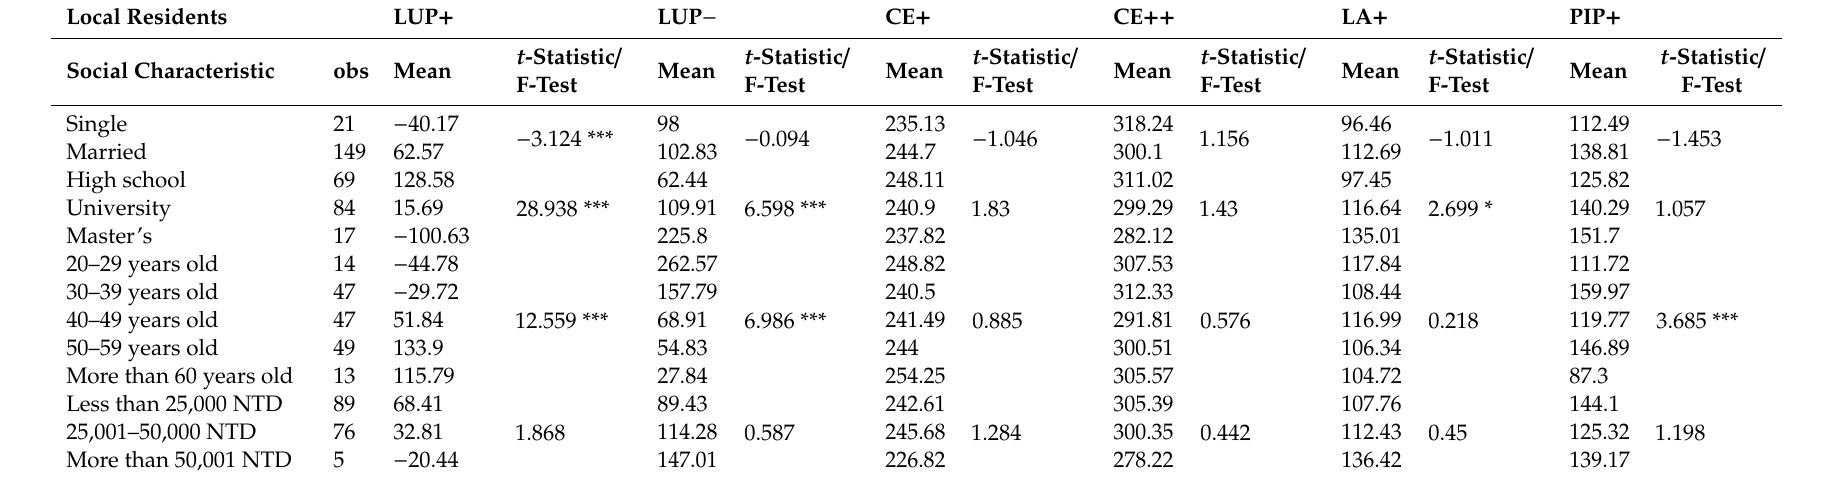
Table 6. Cross-analysis of resident socioeconomic background and willingness to pay for environment